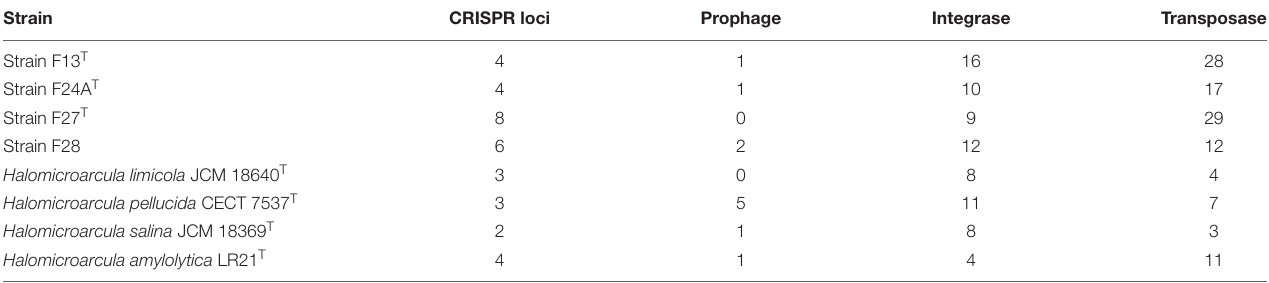
TABLE 2 | CRISPR loci and mobile genetic elements determined in the genomes of strains F13 T , F24A T , F27 T , F28 and the type strains of species of Halomicroarcula . Strain CRISPR loci